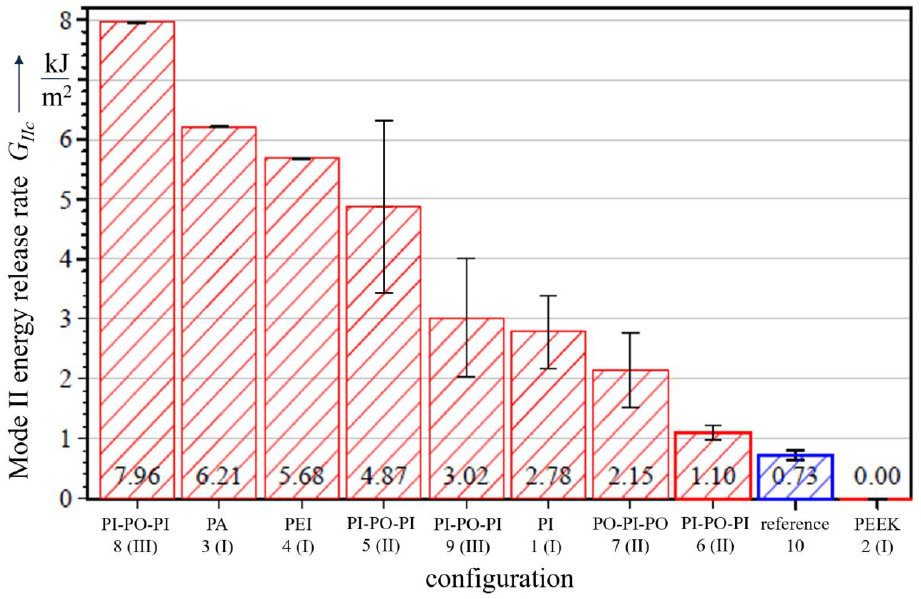
Figure 8. Mode II energy release